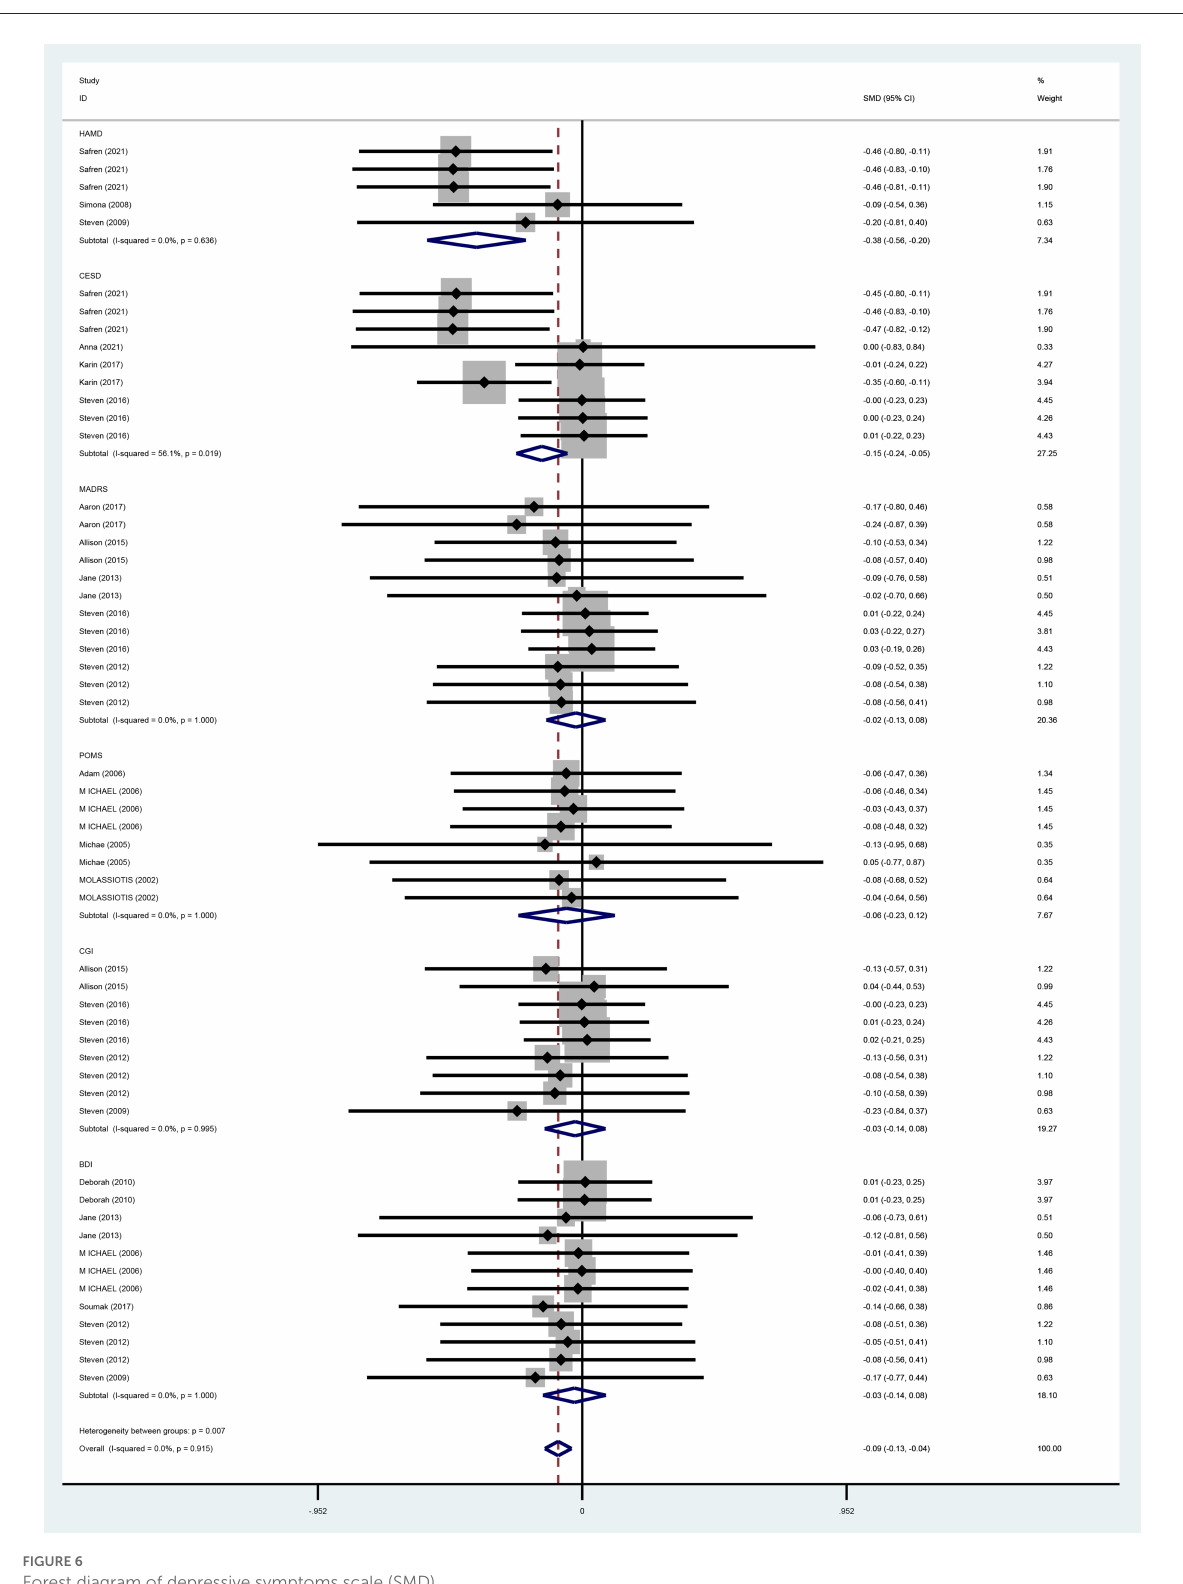
FIGURE6 Forest diagram of depressive symptoms scale